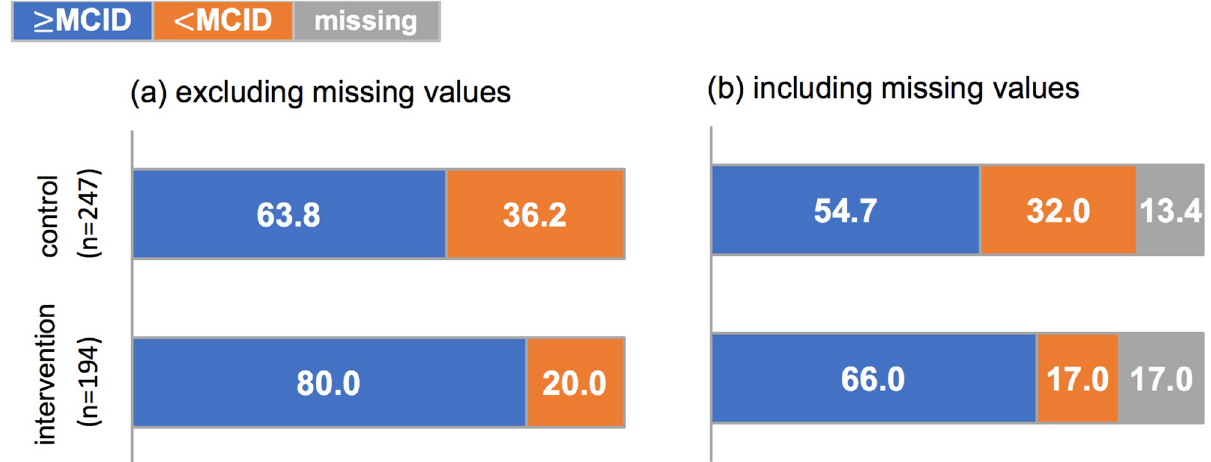
Fig 4. Distribution of clinically significant Improvements in PSFS by trial arm excluding (a) and including (b) missing values.